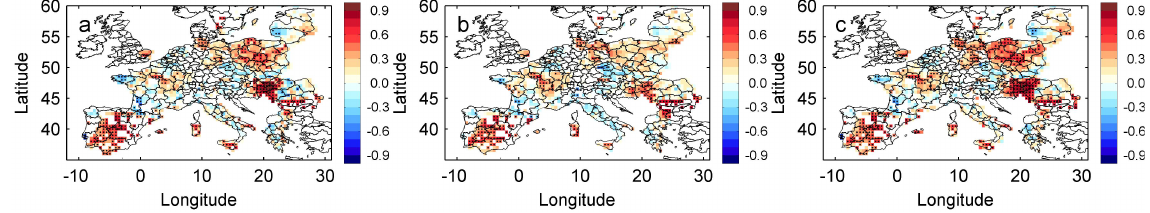
Figure 2. Spatial distribution of Spearman correlation coefficients between the IAV of barley yield and IAV of the corresponding growing season’s (March–June for barley) summed NDVI (a) , GPP (b) , and FAPAR (c) . Significant relationships are marked by black points. Blank region indicates that there is intensive irrigation (with irrigated area fraction ≥ 15%), no crop yield records or a very low ( < 5%) fraction of croplands in those pixels.